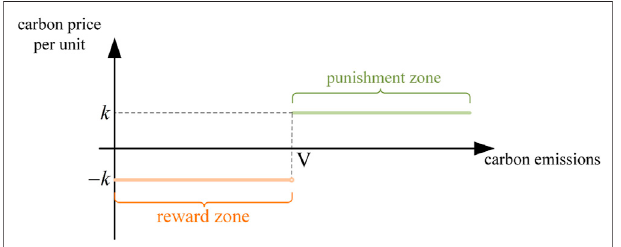
FIGURE 3 | Traditional carbon trading model.